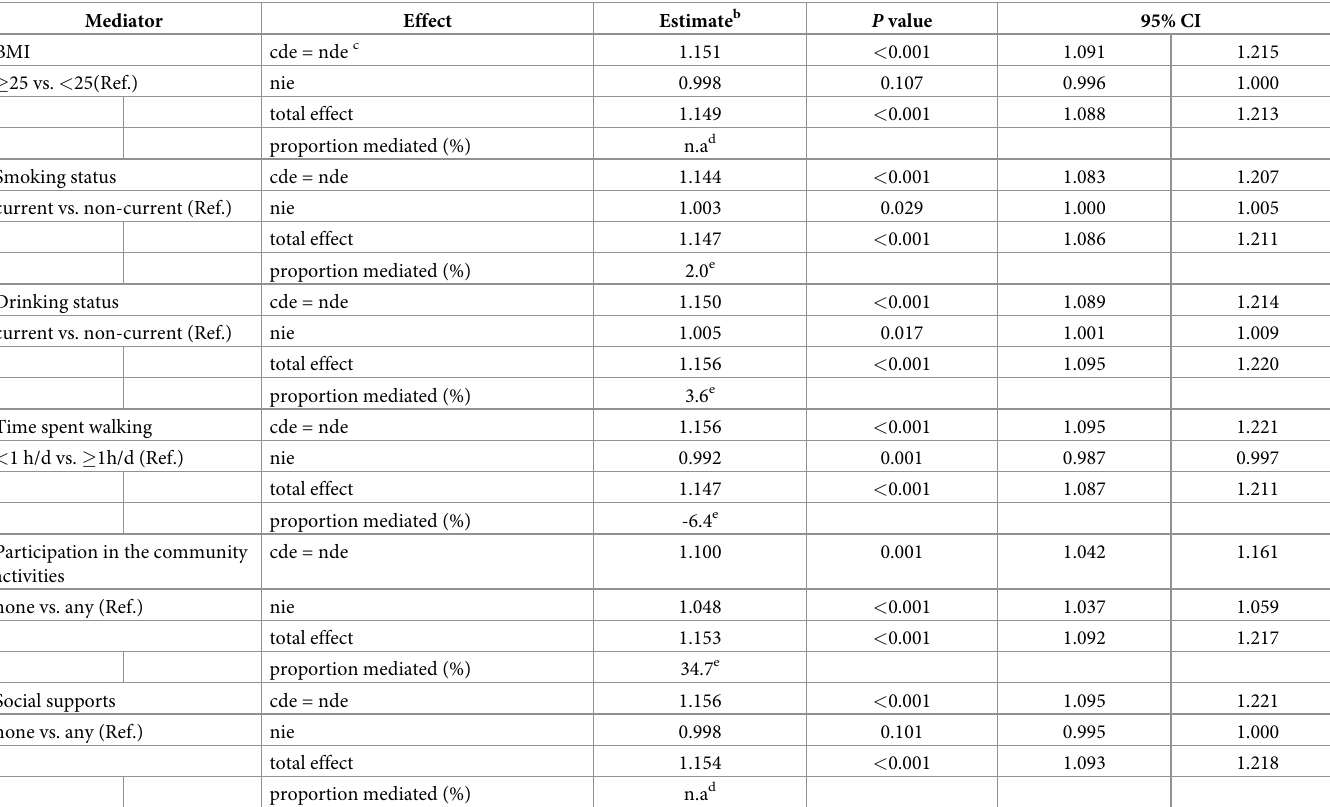
Table 5. Mediation analyses of the relationship between education level [below upper secondary education (Ref.) vs. upper secondary education and above] and incident functional disability (n = 8,680) a , Ohsaki city, Japan,